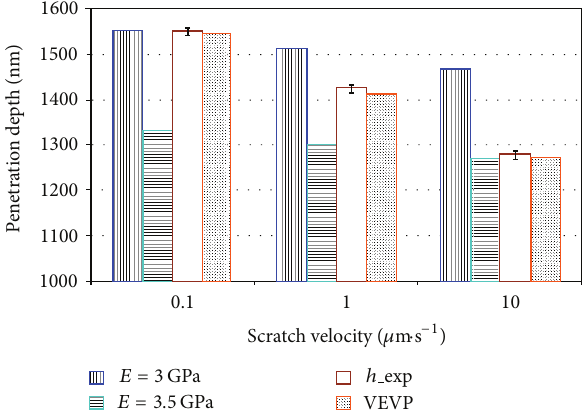
Figure 16: Comparison of experimental results ( ℎ exp) and numer- ical results (elastic-viscoplastic and viscoelastic-viscoplastic) for = 40 mN. The data denoted by 𝐸 = 3.0 GPa (resp., 𝐸 = 3.5 GPa) 𝐹 𝑛 are those calculated with the elastic-viscoplastic model in using a Young modulus of 3.0 GPa (resp., 3.5 GPa). The data denoted VEVP corresponds to the viscoelastic-viscoplastic